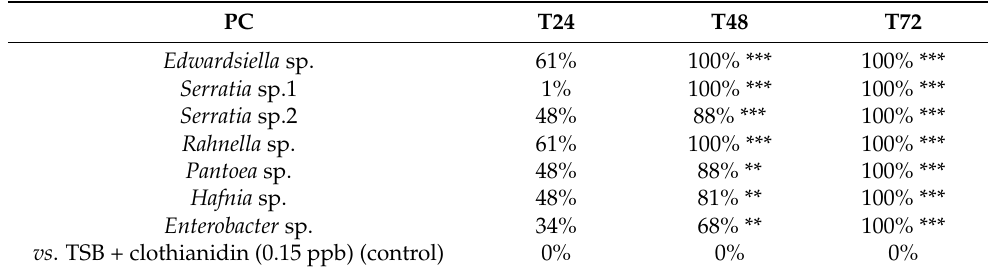
Table 4. Degradation percentage of clothianidin dose by the seven probiotic candidates (PC) isolated from the honeybee gut assessed by LC-MS/MS at T24, T48 and T72. Each percentage of clothiani- din degradation was evaluated based on comparison with the control solution without probiotics (TSB + clothianidin (0.15 ppb)) at T24, T48 and T72. PC T24 T48 T72 Edwardsiella sp. 61% 100% *** 100% *** Serratia sp.1 1% 100% *** 100% *** Serratia sp.2 48% 88% *** 100% *** Rahnella sp. 61% 100% *** 100% *** Pantoea sp. 48% 88% ** 100% *** Hafnia sp. 48% 81% ** 100% *** Enterobacter sp. 34% 68% ** 100% *** 0%